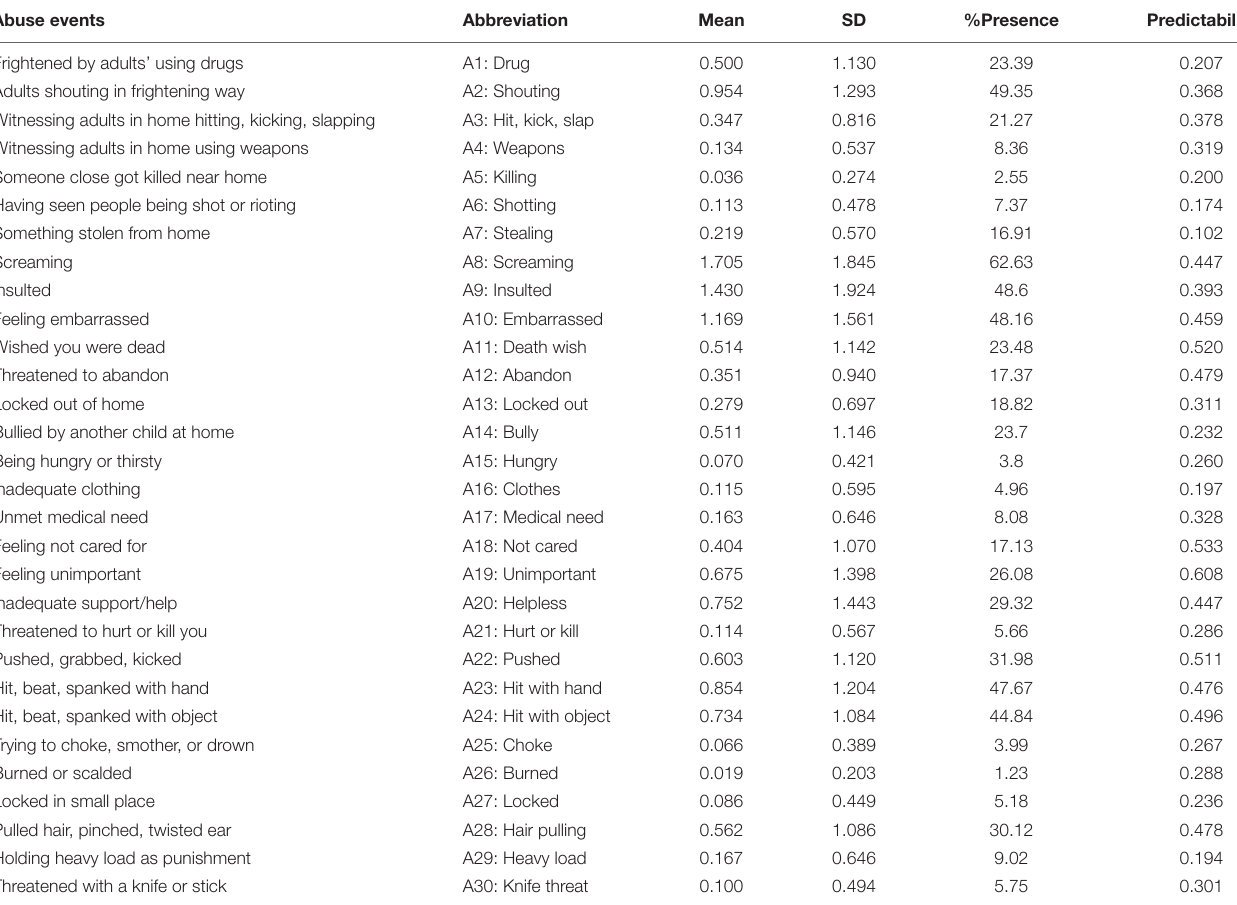
TABLE 3 | Abbreviation, Mean, Standard Deviation, and Presence of ICAST-CH abuse Events. Abuse